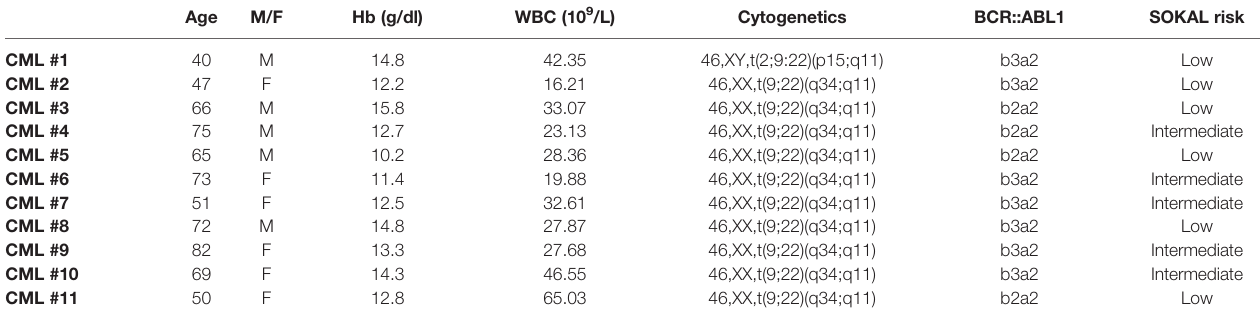
TABLE 1 | Characteristics of the chronic myeloid leukemia